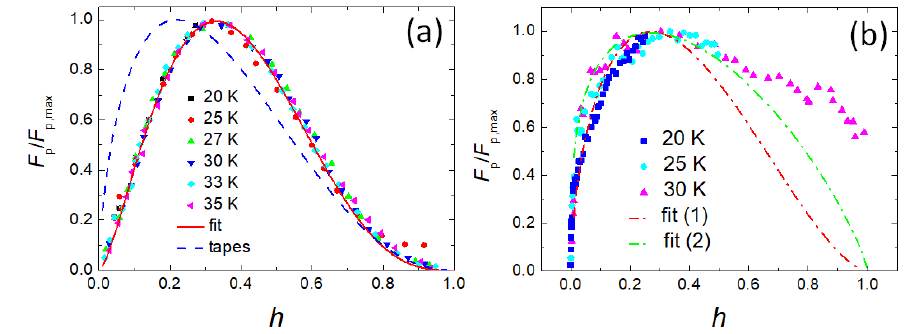
Figure 4. Pinning force scaling, F p / F p ,max versus the reduced field, h = H a / H irr , for the reacted-and-pressed 122 powder sample ( a ) and the HIP-processed 122 sample by Weiss et al. [16] ( b ). In (a), the best fit to the data is shown by a red line ( ). For comparison, the fit curve obtained on 122 tapes [3] is shown with a hatched blue line ( ). In (b), the two fits (1), (2) are attempts to fit the data by the DH model (for the parameters employed, see the main text).